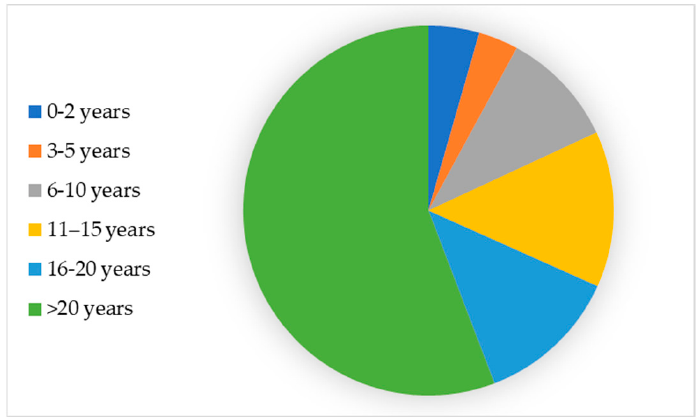
Figure 6. Distribution of tractors changing ownership according to age.